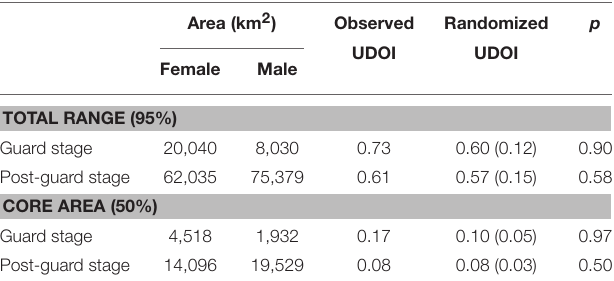
TABLE 1 | Observed and randomized utilization distribution overlap indices (UDOI) (Fieberg and Kochanny, 2005) of the total (95% density contour) and core area (50% density contour) of female and male Cape gannets during the guard and post-guard stages of chick-rearing in the 2015/16 breeding season. Randomized UDOI is indicated as mean ± SD and p is the proportion of random overlaps that were smaller than the observed